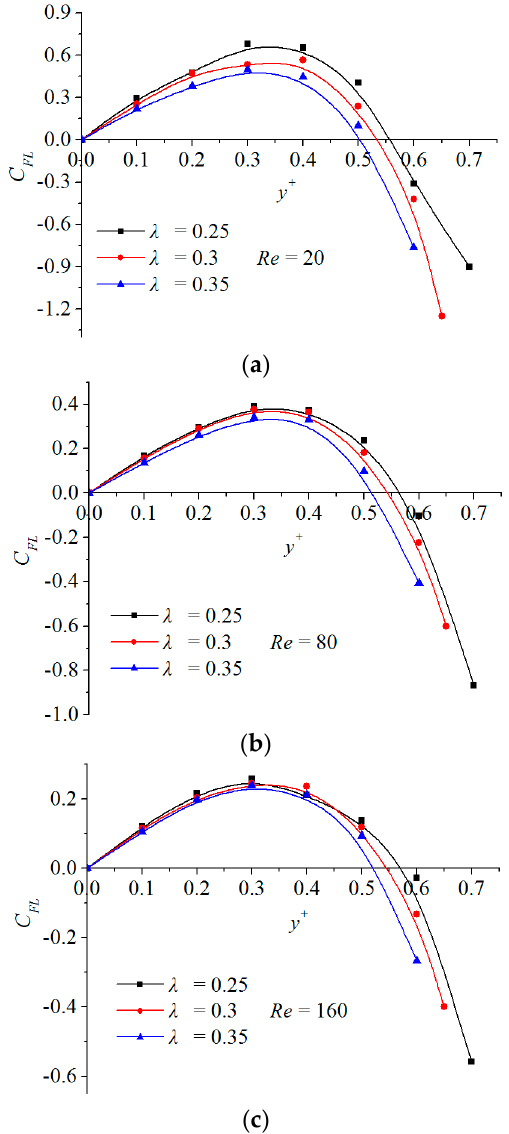
Figure 2. Transverse distributions of the inertial lift force coefficients of particles with different diameters against y + at various Reynolds numbers. ( a ) Re = 20; ( b ) Re = 80; and ( c ) Re = 160.